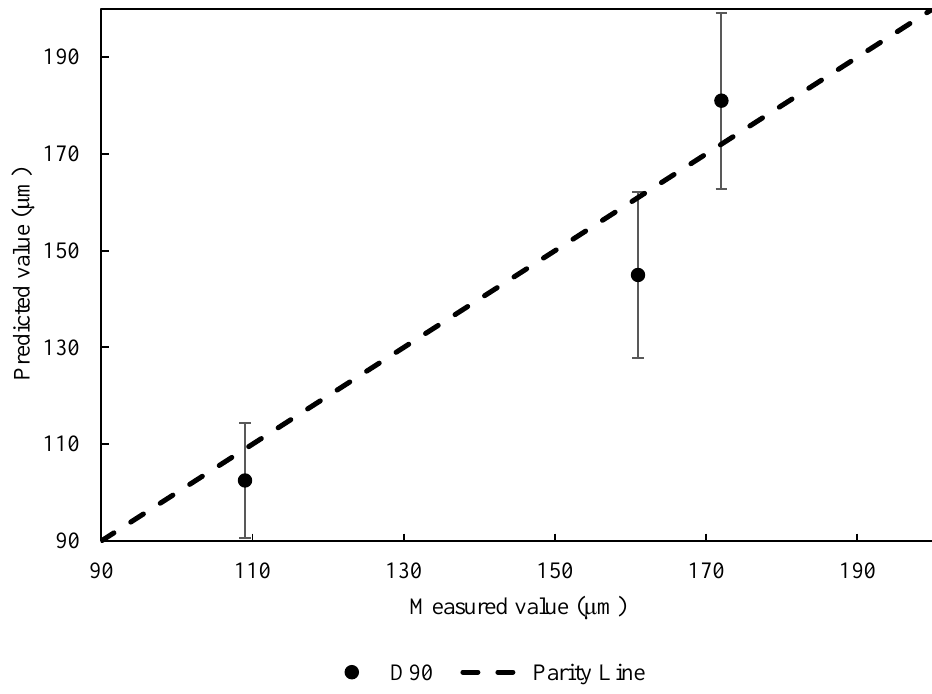
Figure 6. Predicted D90 values versus measured values for selected lab-scale mixing experiments shows good fit of the model predictions to the measured data.